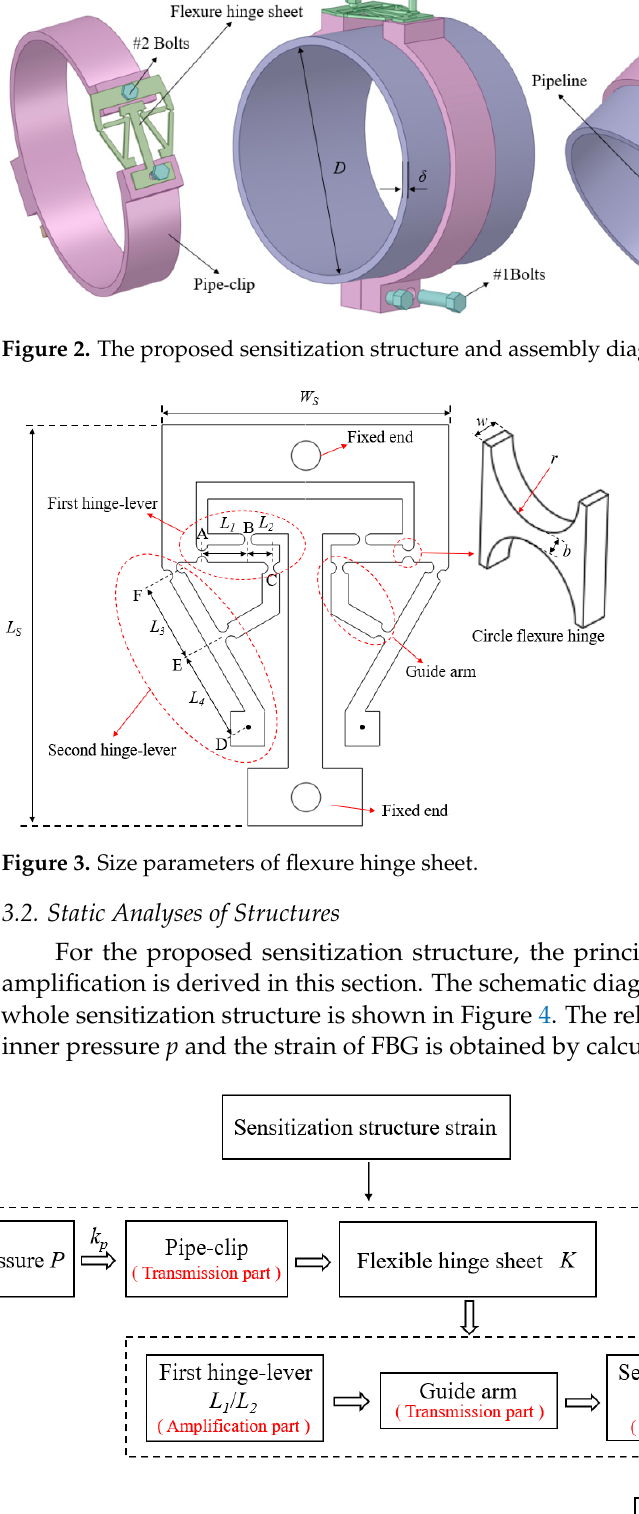
Figure 2. The proposed sensitization structure and assembly diagram.